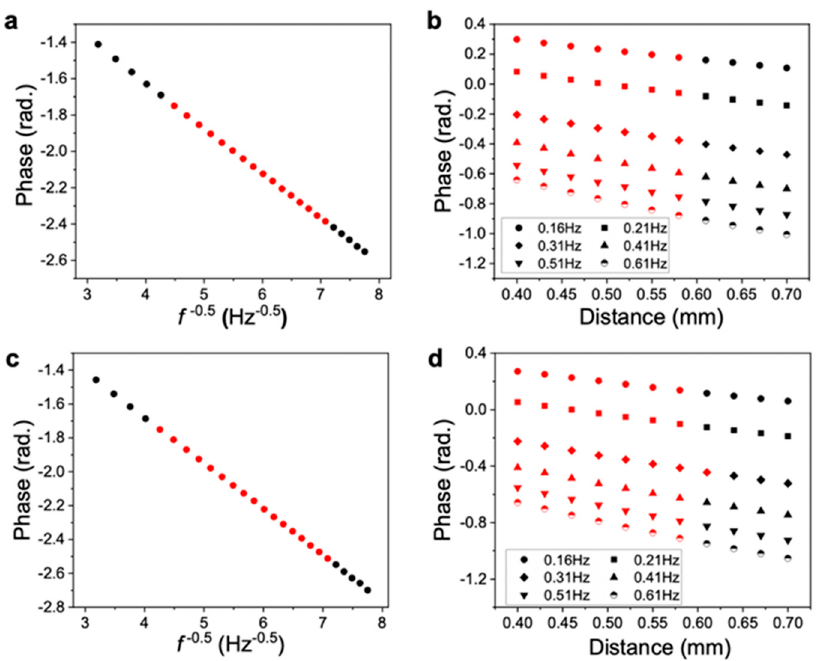
Figure 4. Typical experimental data for measuring the thermal diffusivity. Measurement data of the ChNF film in the ( a ) through-plane and ( b ) in-plane directions. Measurement data of the D-ChNF film in the ( c ) through-plane and ( d ) in-plane directions. The red points were used for linear fitting to determine the slopes.